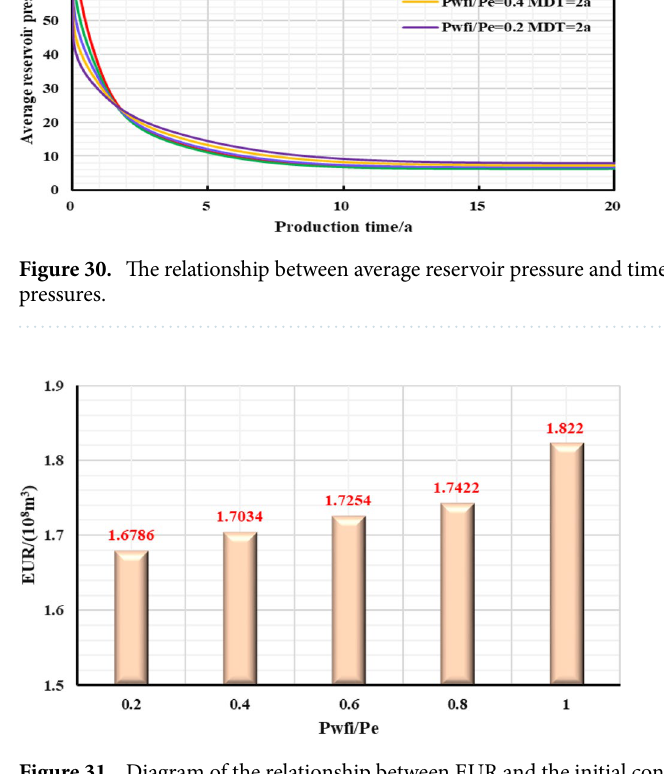
Figure 31. Diagram of the relationship between EUR and the initial controlled pressure.